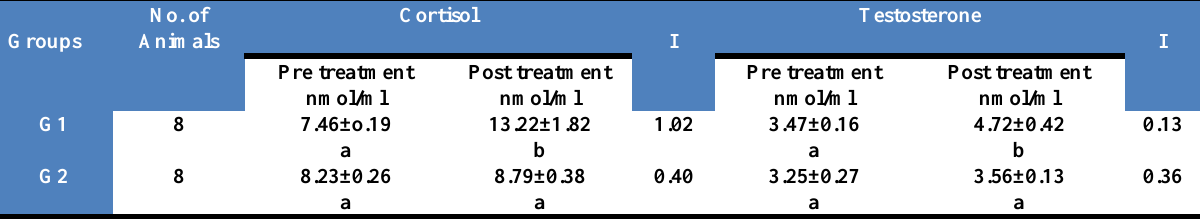
Table, 4: Effect of cumin seeds on mass and individual motility of sperm. (M ±SE) No. of Mass motility Groups Animals Pre treatment % G1